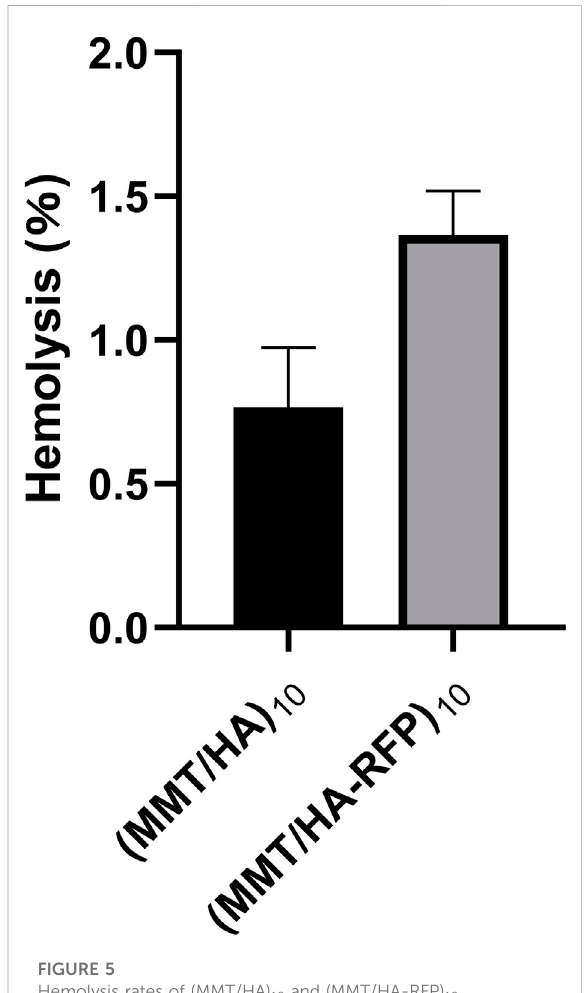
FIGURE 5 Hemolysis rates of (MMT/HA) 10 and (MMT/HA-RFP) 10 multilamellar fi